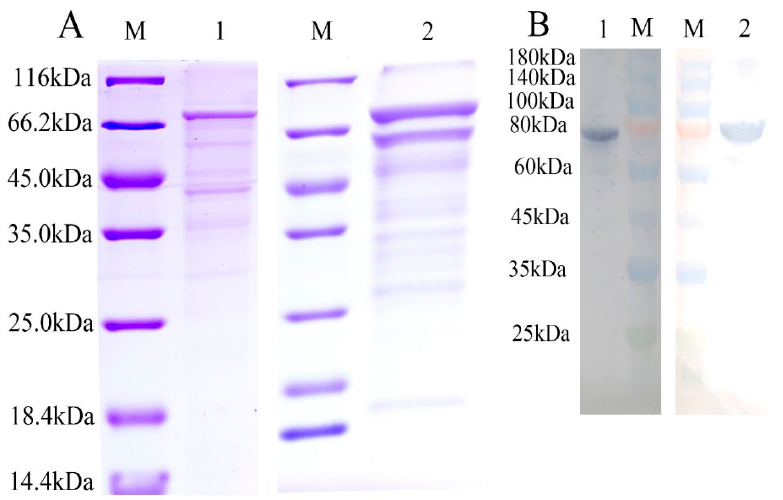
Figure 8. SDS-PAGE ( A ) and Western blot ( B ) analysis of two purified recombinant ToTLR5s. ( A ) Lane M: standard protein marker; lane A1: purified recombinant ToTLR5M; lane A2: purified recombinant ToTLR5S. ( B ) Lane M: standard protein marker; lane B1: rToTLR5M; lane B2: rToTLR5S.